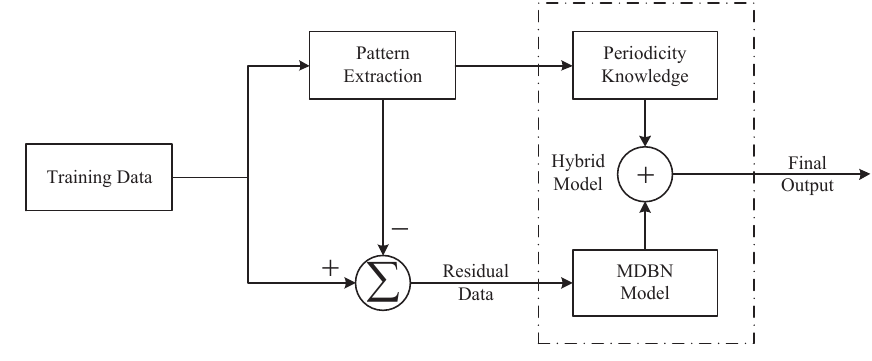
Figure 3. The structure of the hybrid